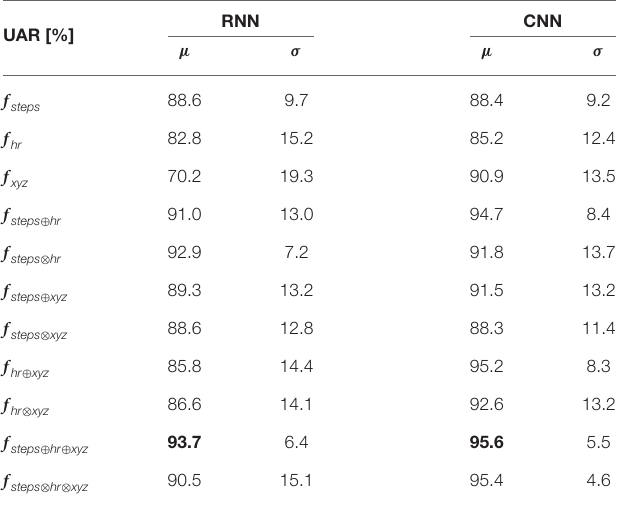
TABLE 2 | Summary of the descriptive statistics ( µ : mean, σ : standard deviation) computed from the UAR scores obtained when assessing the unimodal and the multimodal binary classification-based end-to-end models using nested LOSO-CV.